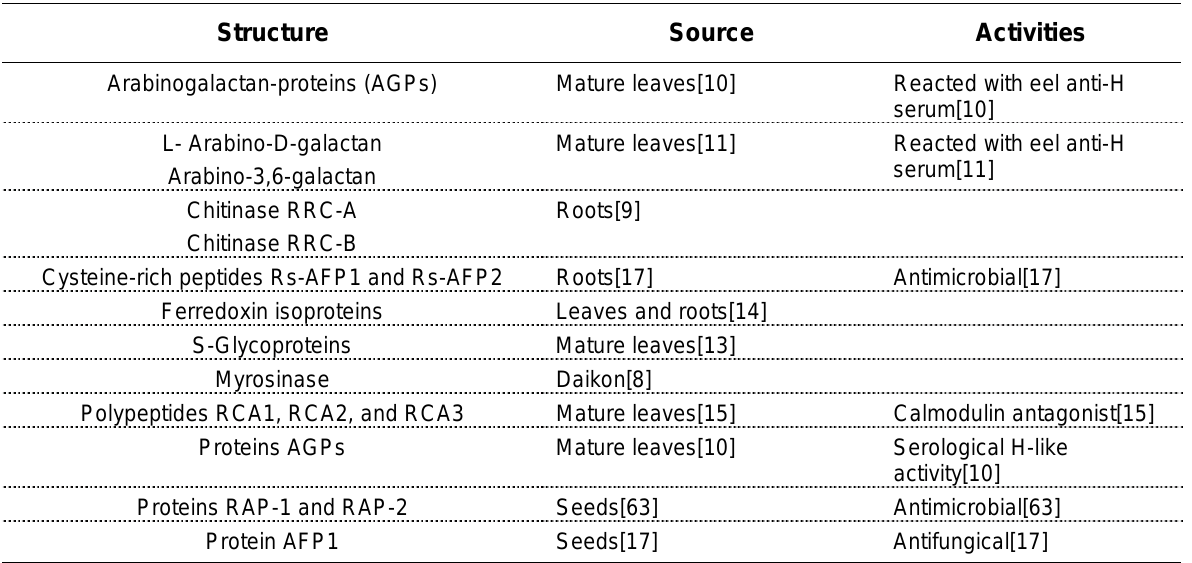
Proteins Isolated from Radish